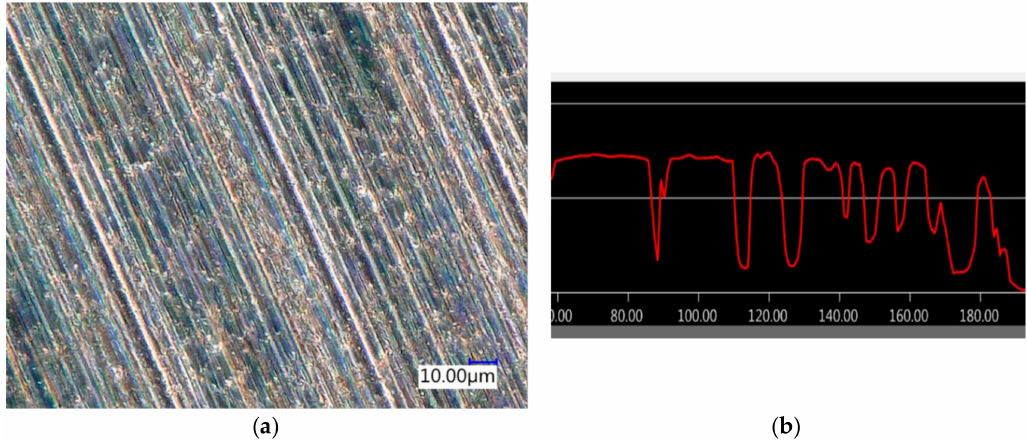
Figure 11. Microstructure ( a ) and profile ( b ) of machined surface under MQCL condition with pure emulsion-based